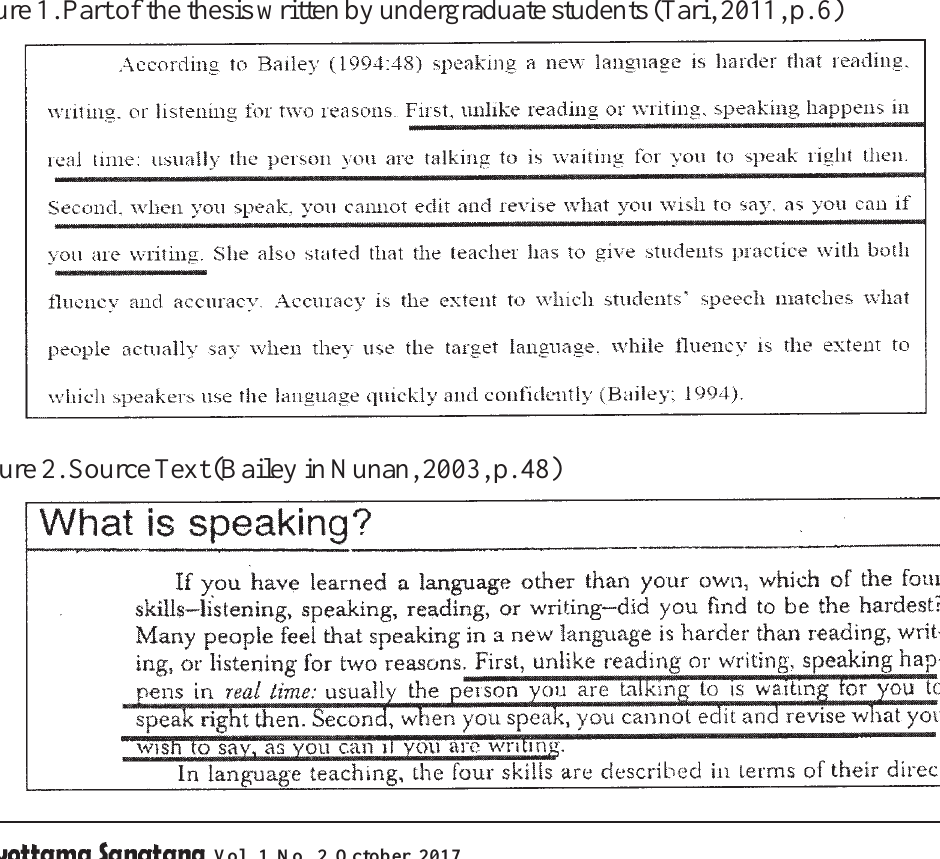
Figure 1. Part of the thesis written by undergraduate students (Tari, 2011, p. 6)